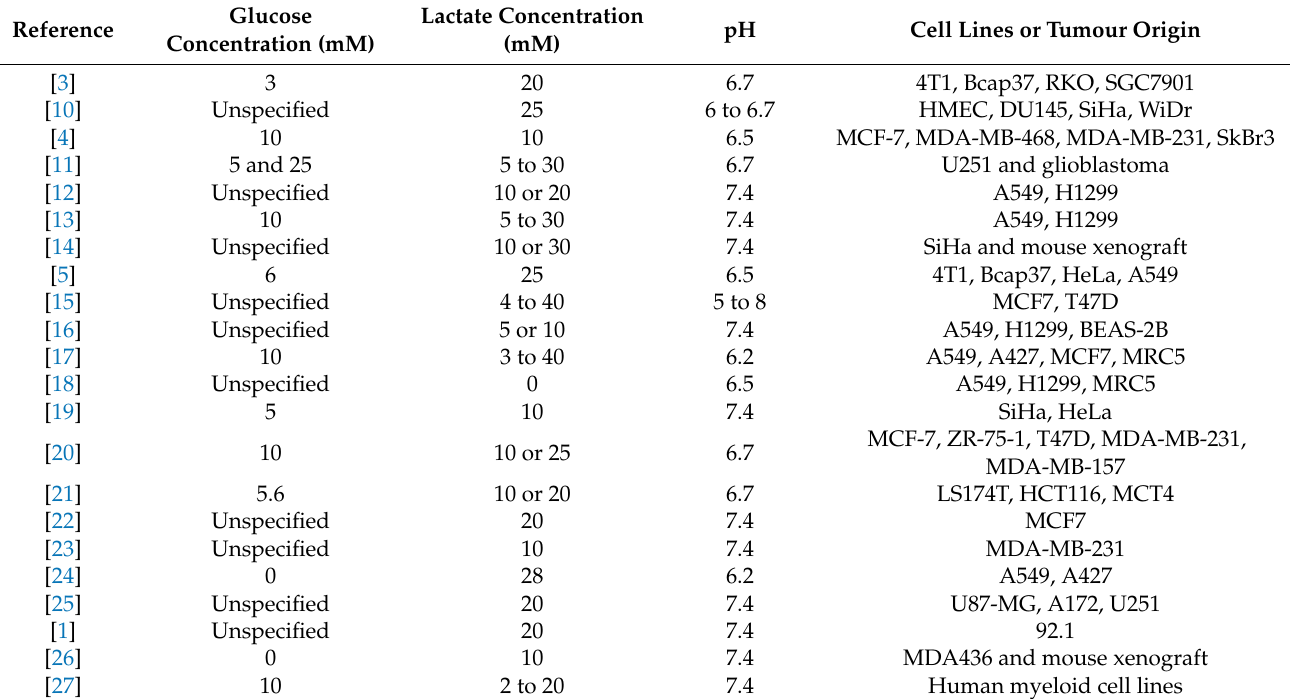
Table 1. The presented studies addressing lactic acidosis’ impact on cell energy metabolism are performed under various conditions. For each reference, the tested cell line or cancer type and medium conditions (glucose concentration, lactate concentration, and pH) are specified. When unspecified, the pH value was assumed to equal